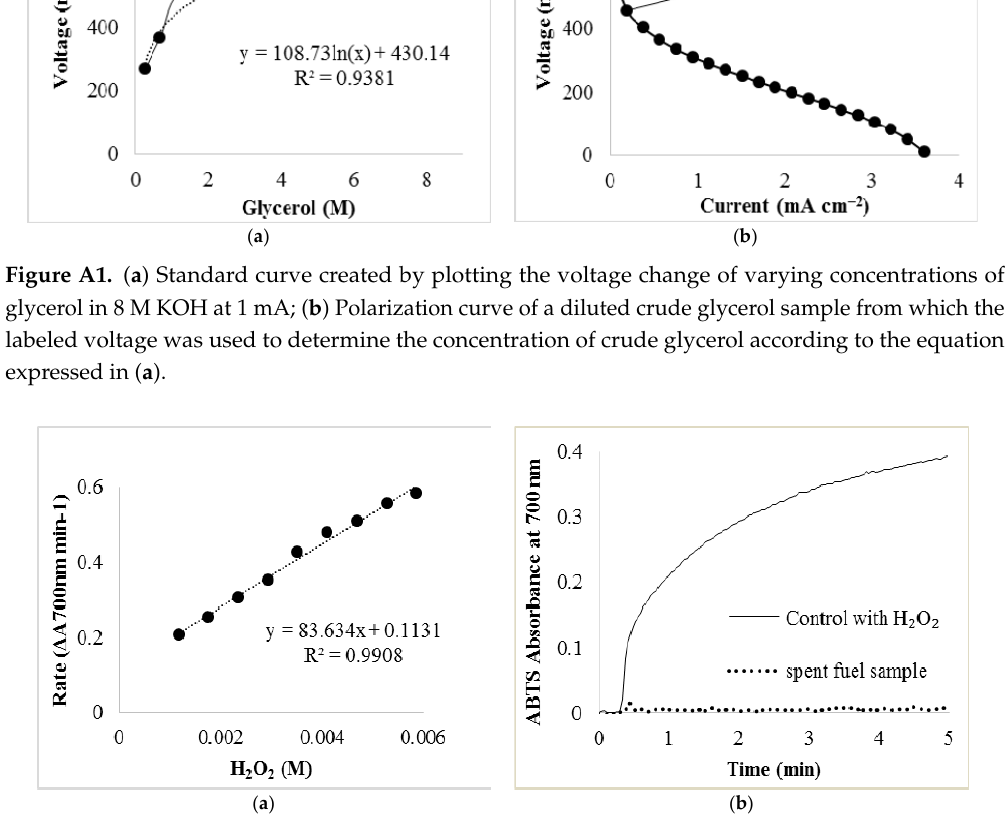
Figure A2. ( a ) ABTS assay standard curve based on the enzyme activities of myoglobin which was used to identify the concentration of H 2 O 2 in the solution after glycerol oxidation; ( b ) One of the curves with 0.02 mL H 2 O 2 comparing with spent fuel sample from glycerol oxidation. The control is 0.02 mL of H 2 O 2 in 0.2 mL ABTS, 2.6 mL of pH 7.5 Tris buffer, and 0.2 mL of 1 mg mL -1 myoglobin. In spent fuel sample, no H 2 O 2 was added additionally.